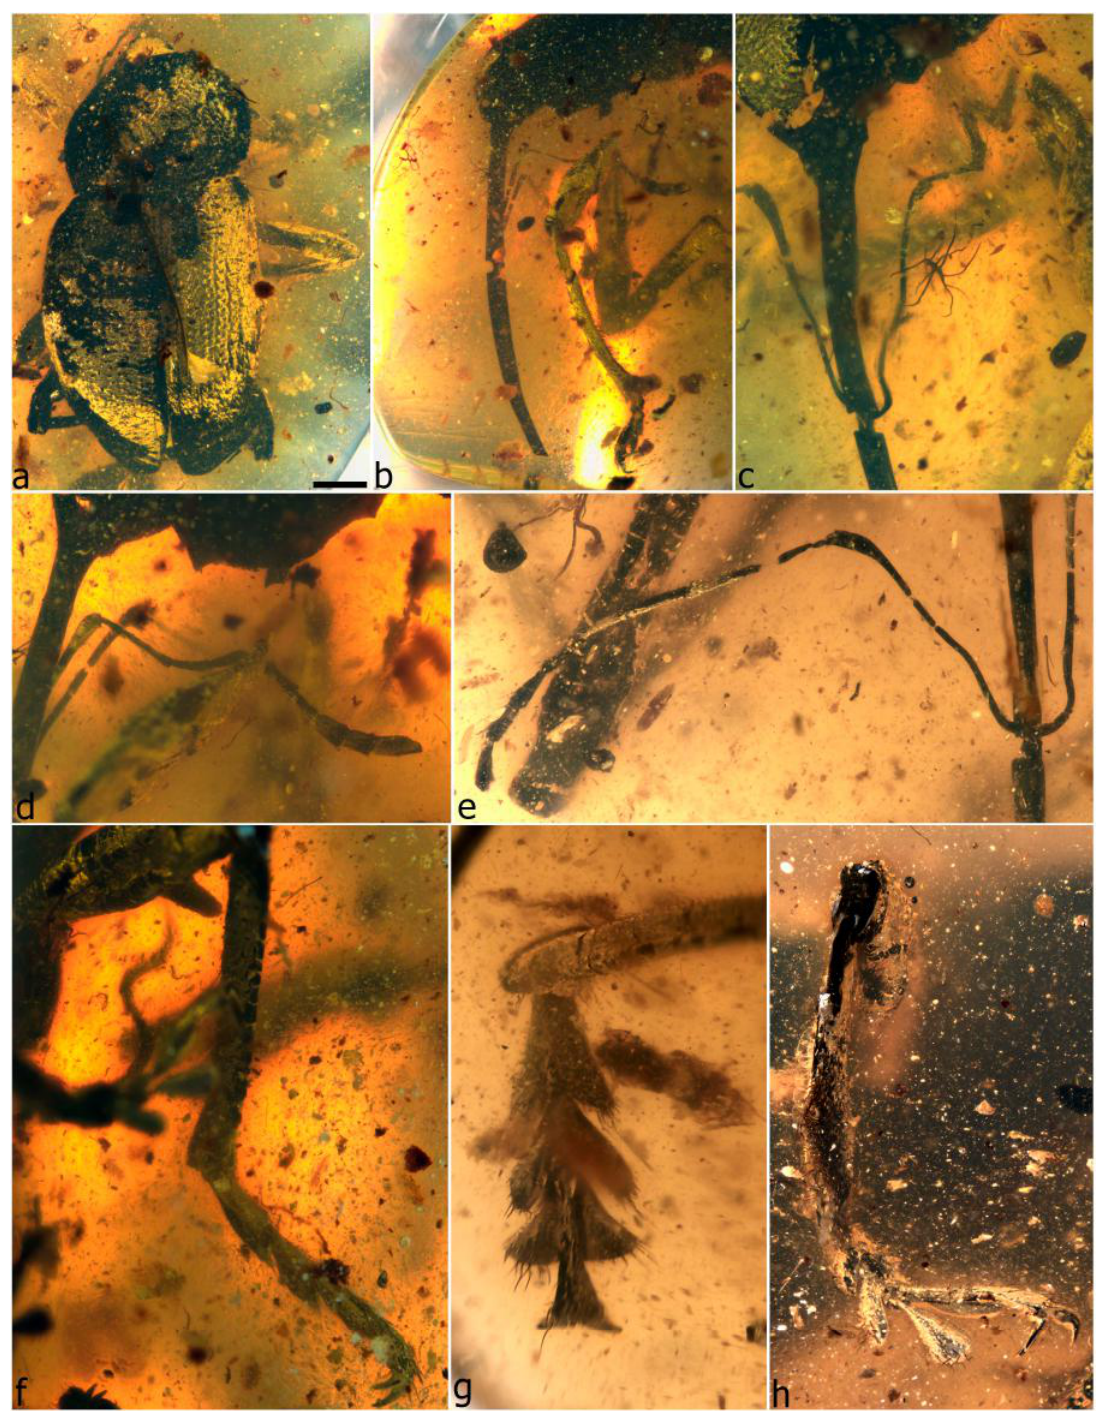
Figure 29. Cetionyx batiatus sp. n., holotype. Habitus, dorsal ( a ); head, left lateral ( b ); head and antenna, dorsal oblique ( c ); detail of left antenna, dorsal oblique ( d ); detail of right antenna, dorsal ( e ); mesotibia and -tarsus ( f ); mesotarsus, dorsal ( g ); mesotibia and -tarsus ( h ). Scale bar: 1.0 mm (a).